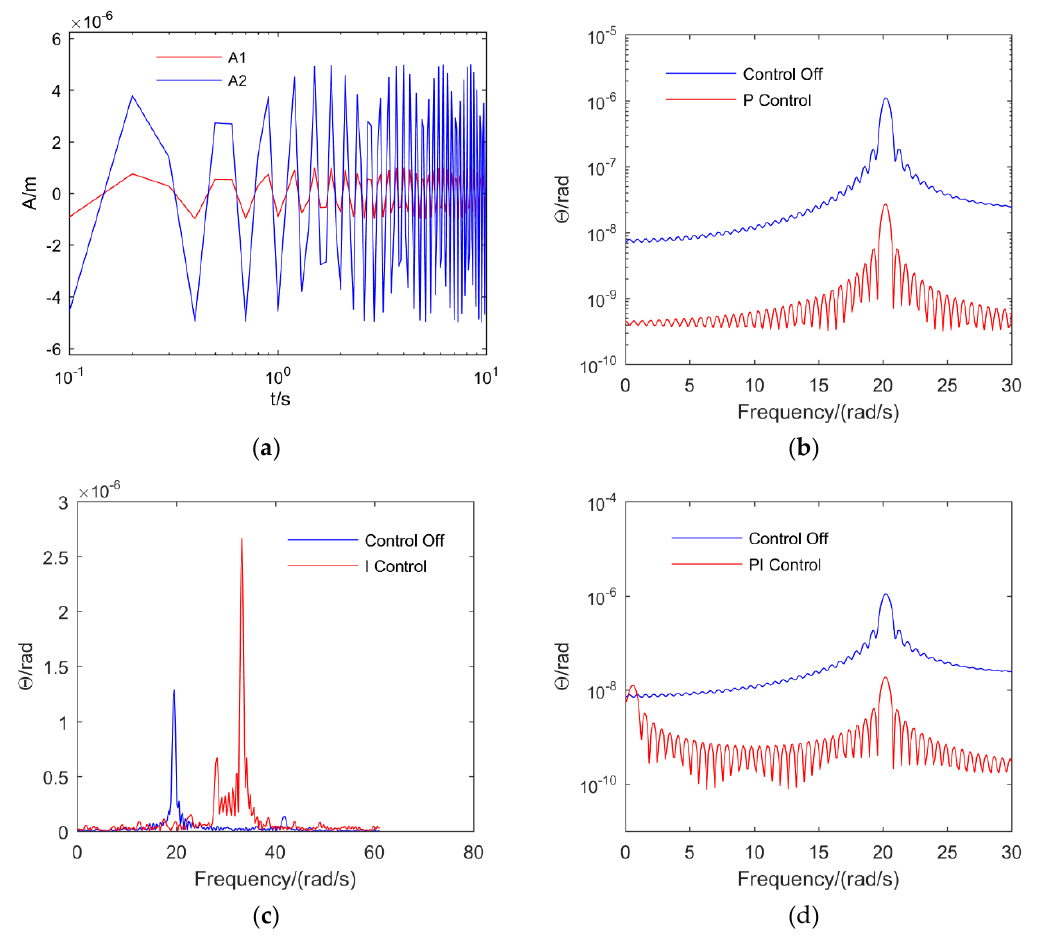
Figure 16. 20 rad/s harmonic excitation with and without the control of the spatial filter output light angle response peak comparison: ( a ) Harmonic excitation signal; ( b ) velocity feedback gain P g control; ( c ) displacement feedback gain I g control; ( d ) velocity feedback gain P g and displacement feedback gain I g joint control.